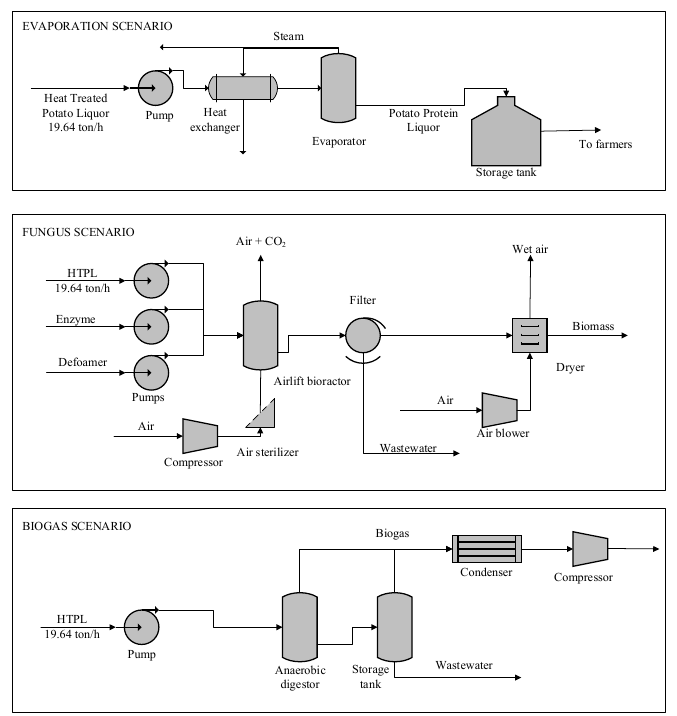
Figure 1. Process flow diagram of the three scenarios studied in this work.